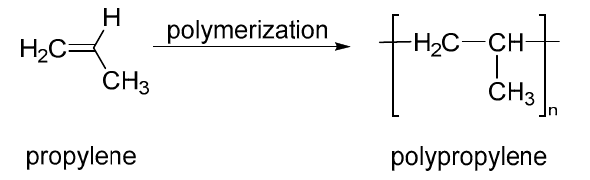
Figure 8. Synthesis of polypropylene.